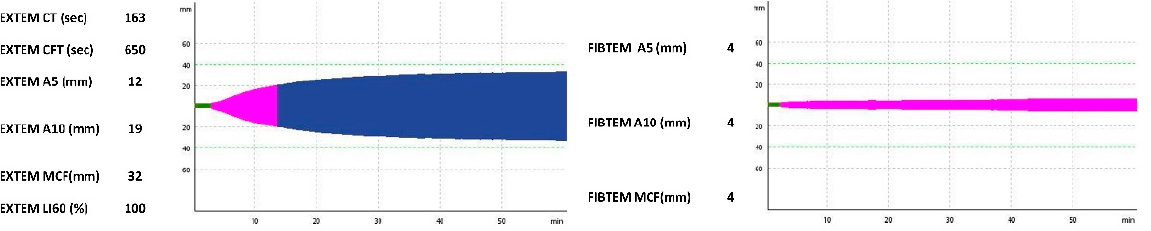
Figure 4. Hemostatic profile of the patient on the day of clinical deterioration, as illustrated by ROTEM EXTEM and FIBTEM graphic representation and numerical results. Abbreviations: CT, clotting time (min, green colour); CFT, clot formation time (min, pink colour); A5 and A10, clot am- plitude at 5 and 10 min (mm); MCF: maximum clot firmness (mm); LI60, lysis index at 60 min (%).